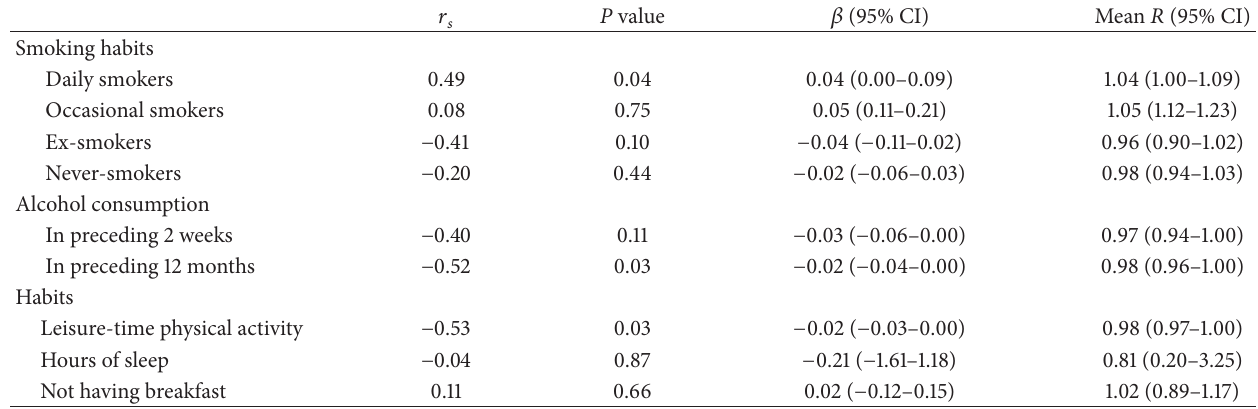
Table 1: Association analysis of the differences in migraine prevalence by the percentage of population in each region presenting a series of lifestyle habits.